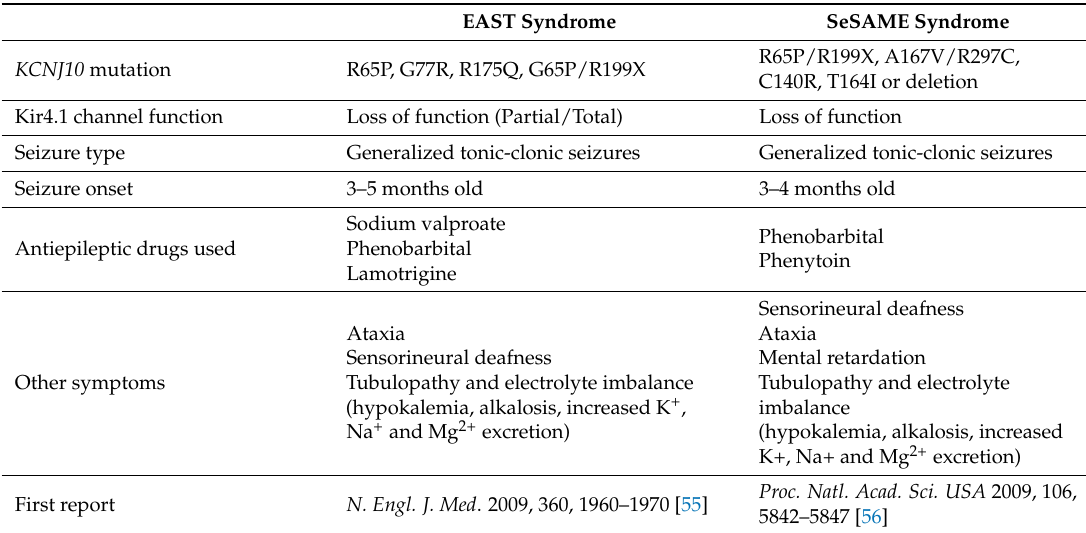
Table 2. Clinical features of EAST/SeSAME syndrome associated with KCNJ10 mutations in